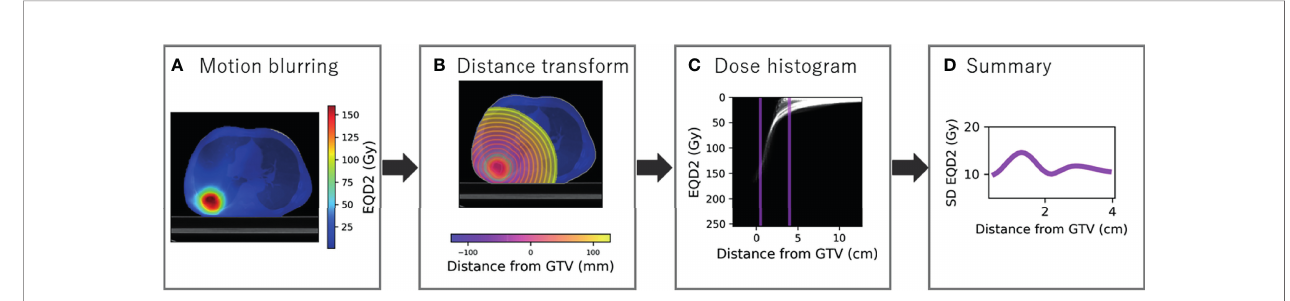
FIGURE 2 | Radial histogram methodology for dose distribution. (A) The dose distribution is blurred for respiratory motion using 50% as reference and converted to a biologically equivalent dose in 2 Gy per fraction (EQD2). (B) The signed distance transform map is created to sample dose at distance from the GTV and cropped inside the body. (C) Radial histogram which is cropped to 0.5 to 4 cm. (D) Standard deviation of EQD2 at distance from the GTV summarised from the cropped radial